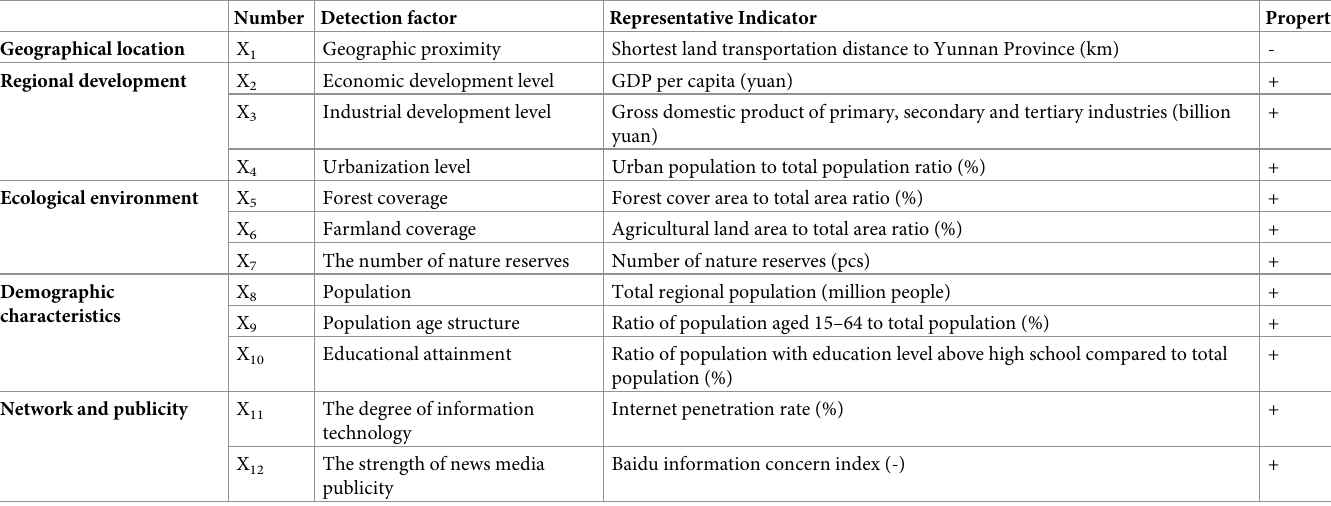
Table 3. Index system of influencing factors of internet attention. Number Detection